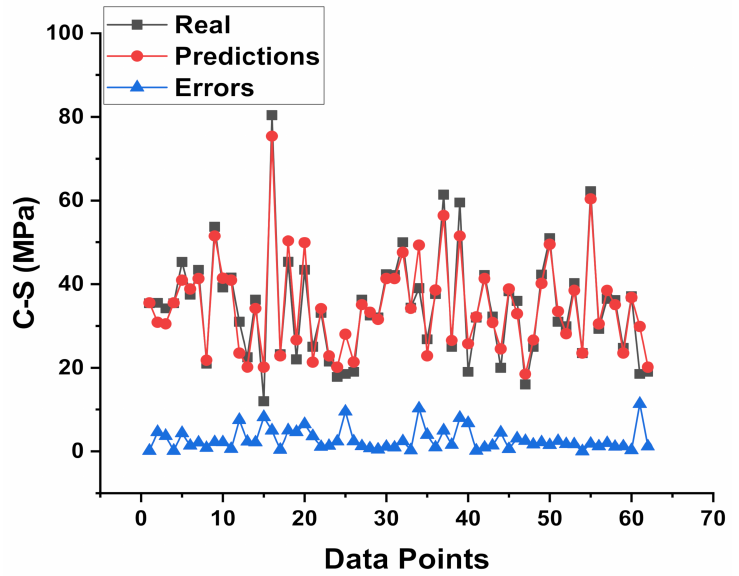
Figure 6. Experimental and predicted dispersal of the results along with the scattering of their errors for the SVM model.